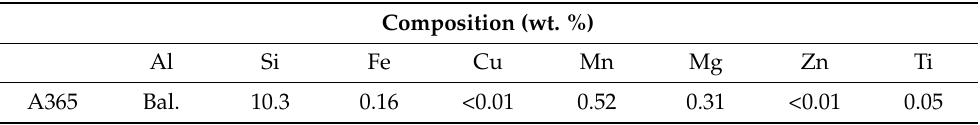
Table 1. Nominal composition of HPDC A365 base material provided by Rio